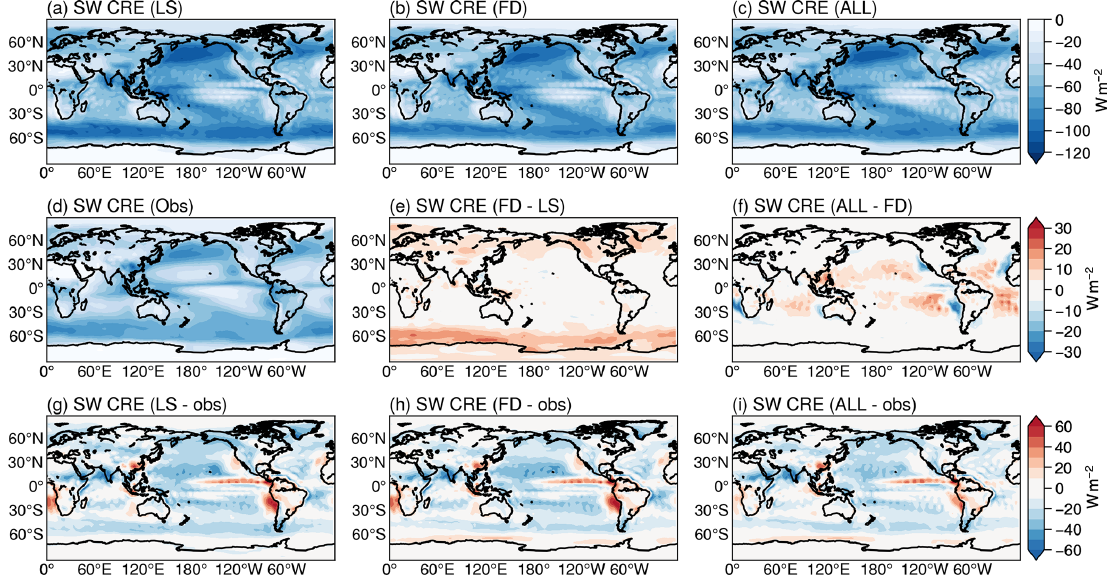
Figure 10. The same as Fig. 7 but for shortwave (SW) cloud radiative effect (CRE; Wm − 2 ) at TOA. The observed SW CRE is from the CERES-EBAF data